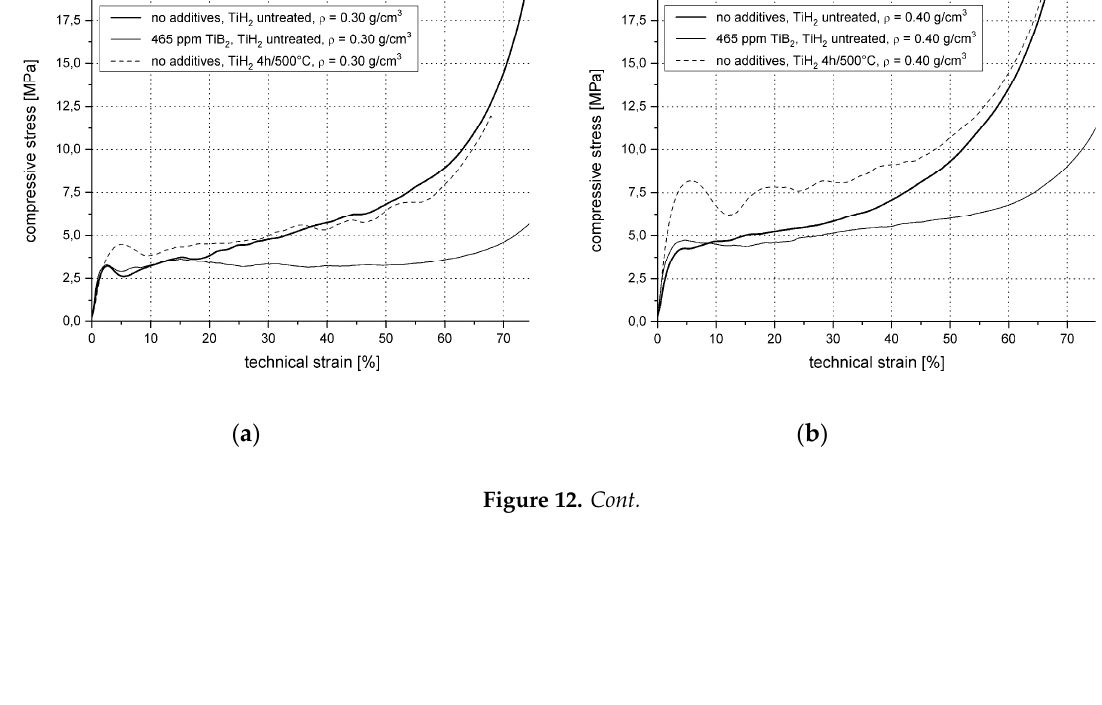
Figure 11. Foam microstructure, ( a – c ) Barker etching emphasizing grain sizes, ( d – f ) expression of the eutectic phase. ( a , d ) Reference material AlSi7 with conventional, as received foaming agent, ( b , e ) with 465 ppm Sr and ( c , f ) with 465 ppm Ti as TiB 2